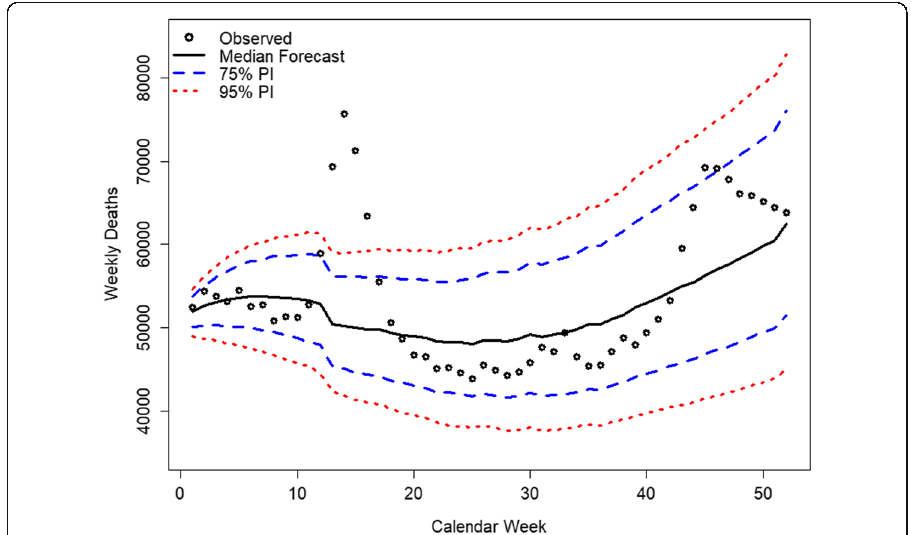
Fig. 6 Observed and predicted weekly deaths in 2020 for the 19 study countries. Sources: Human Mortality Database (2021); Computations and design by the